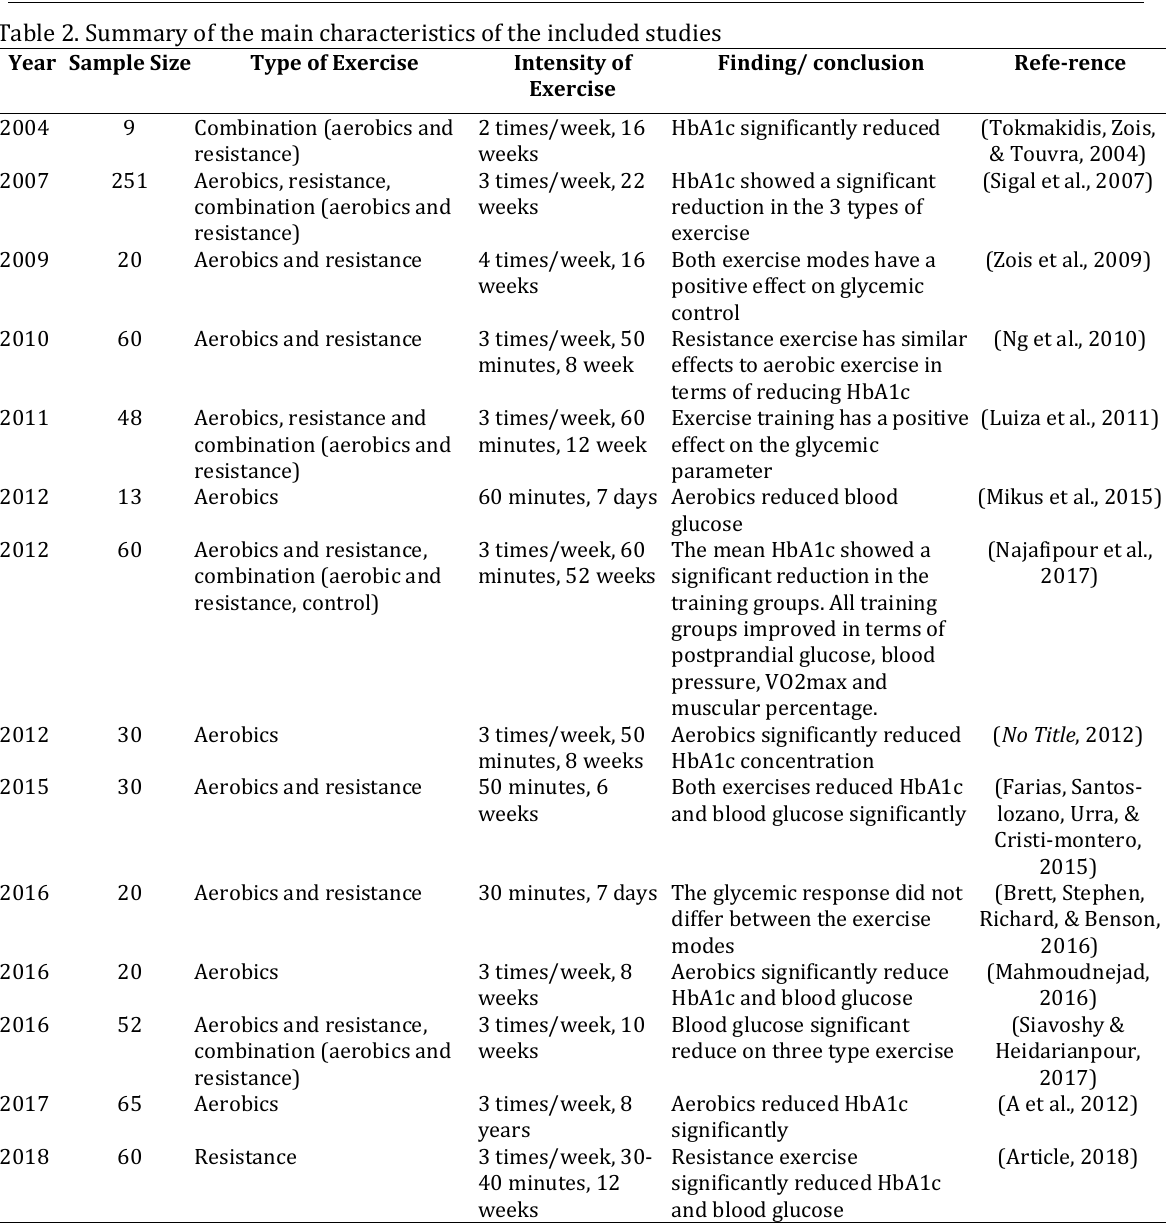
Table 2. Summary of the main characteristics of the included studies Year Sample